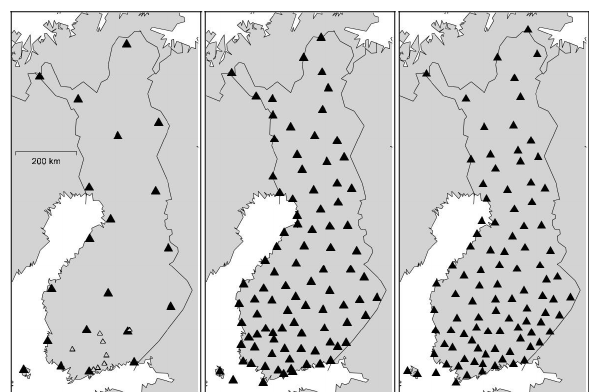
Figure 2: Nationwide NRTK networks in Finland. FinnRef (left) is operated by the FGI/NLS, TrimNet (middle) is operated by Geotrim Oy and HxGN SmartNet (right) is operated by Leica Geosystems Finland. Test points are shown with small white triangles in the